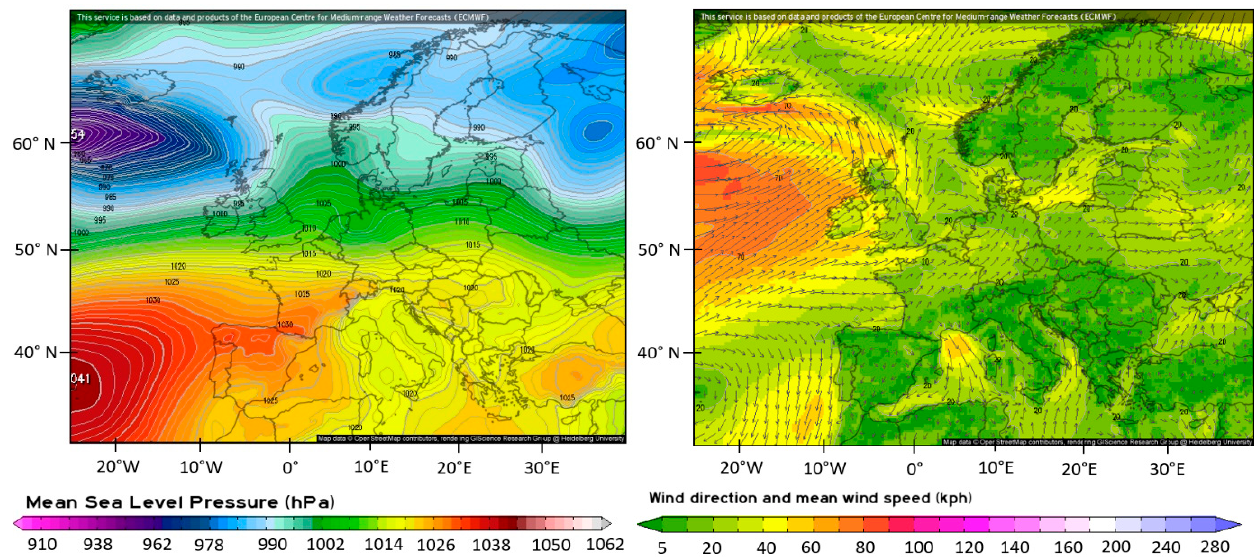
Figure 4. Sea-level pressure (left) and 10 m wind directions and speeds by ECMWF reanalysis for 20 February 2022. On the left, colors indicate the mean sea-level pressure and lines highlight the isobars. On the right, arrows indicate the wind direction and the colors indicate the wind speeds. Source: (meteorologix.com, accessed on 8 February 2023).